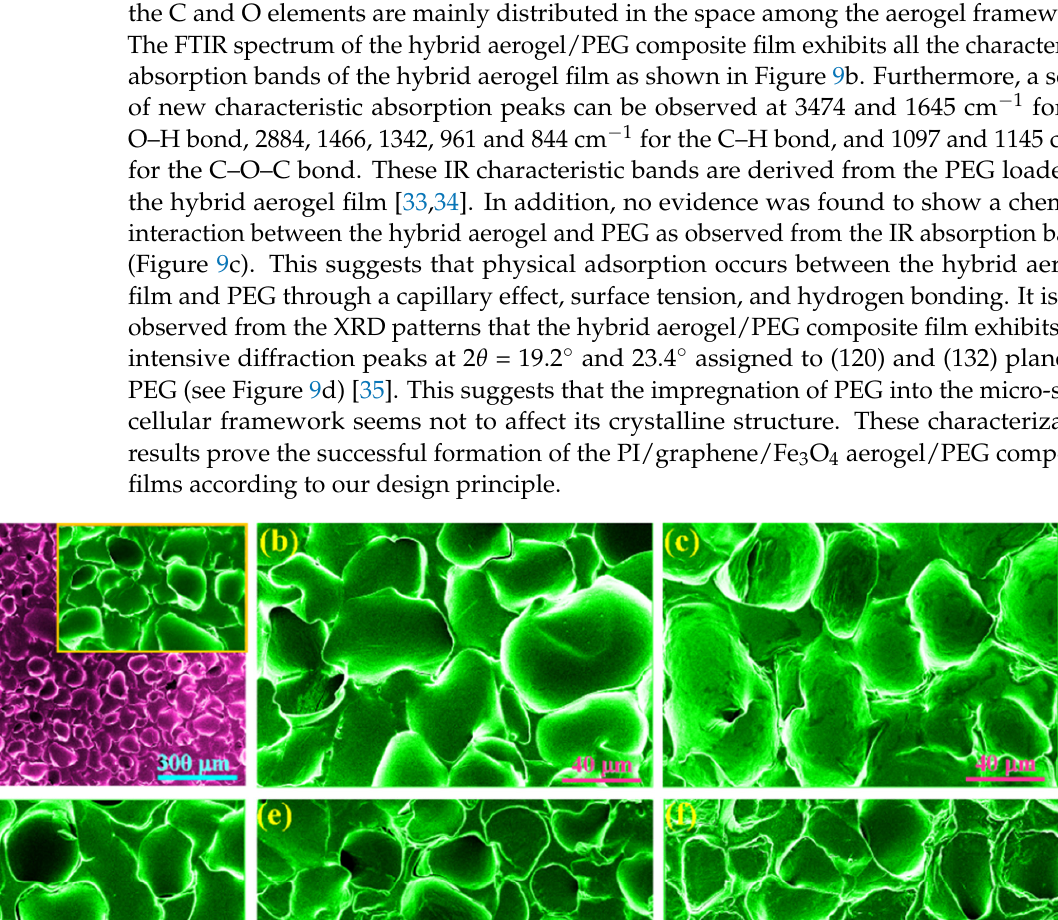
Figure 7. Mercury intrusion and pore size-distribution curves of ( a ) pure PI aerogel film and the PI/graphene/Fe 3 O 4 hybrid aerogel films with a graphene content of 5 wt% and different Fe 3 O 4 contents of ( b ) 0 and ( c ) 6 wt%.